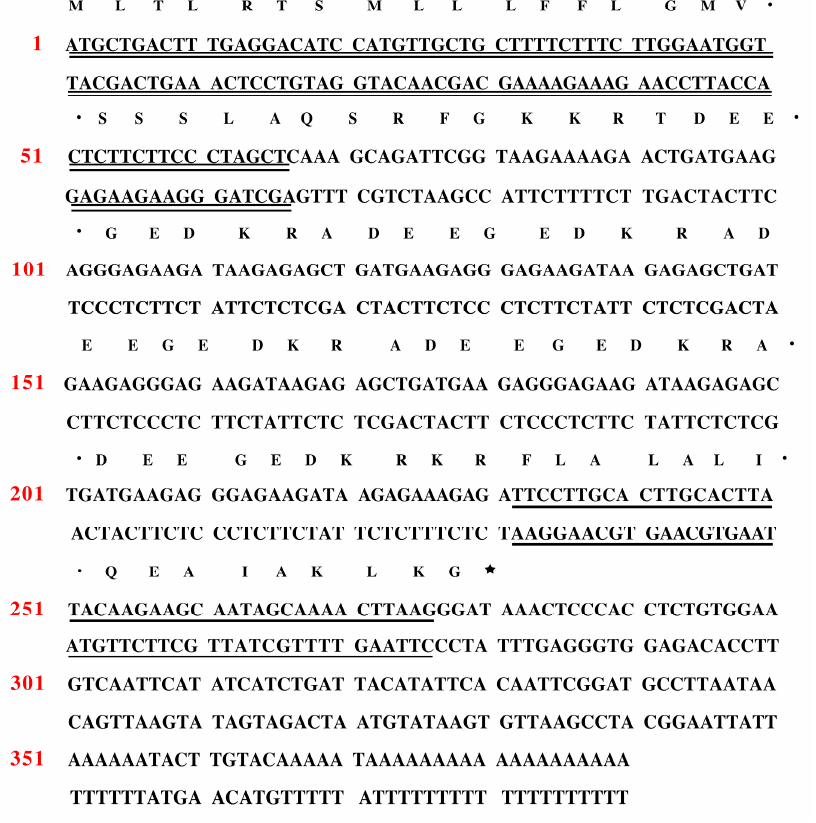
Figure 1. Nucleotide and translated amino acid sequences from the open reading frame of the biosynthetic precursor of novel peptide, kassporin-KS1, from a Kassina senegalensis skin secretion derived from the cDNA library. Double underlining, single underlining, and an asterisk are used to indicate the signal peptide, mature kassporin-KS1 (QUB-1641), and stop codon, respectively.